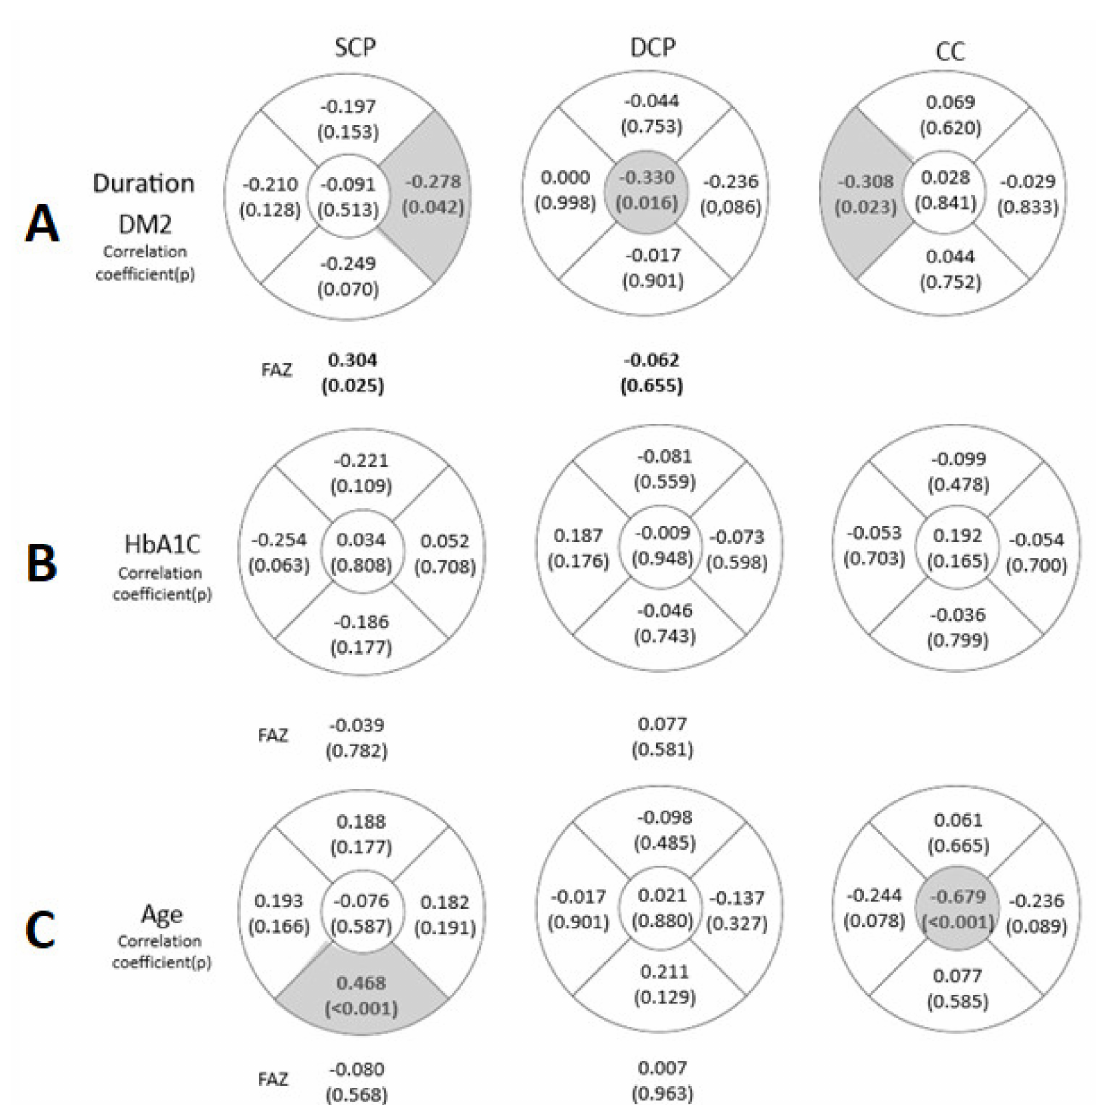
Figure 5. Correlation between type 2 diabetes mellitus (DM2) duration ( A ), glycosylated haemoglobin (HbA1c) (%) ( B ) and age ( C ) in patients with DM2 in the 5 areas and in the FAZ of the SCP, DCP and CC. The values that reached statistical significance ( p < 0.05) are shown in